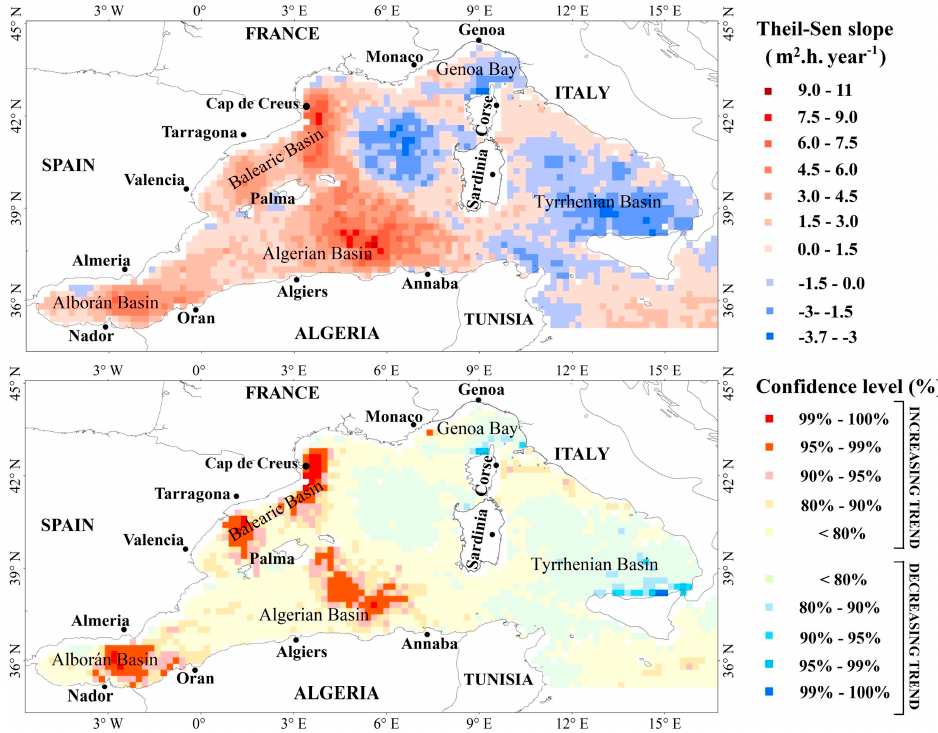
Figure 6. Spatial distribution of long-term trends (Theil-Sen slope in m 2 · h · year − 1 ) of the annual average of Storm Power Index ( SPI ) ( upper panel ) and their significant trends according to the Mann Kendall test at different confidence levels ( lower panel ).